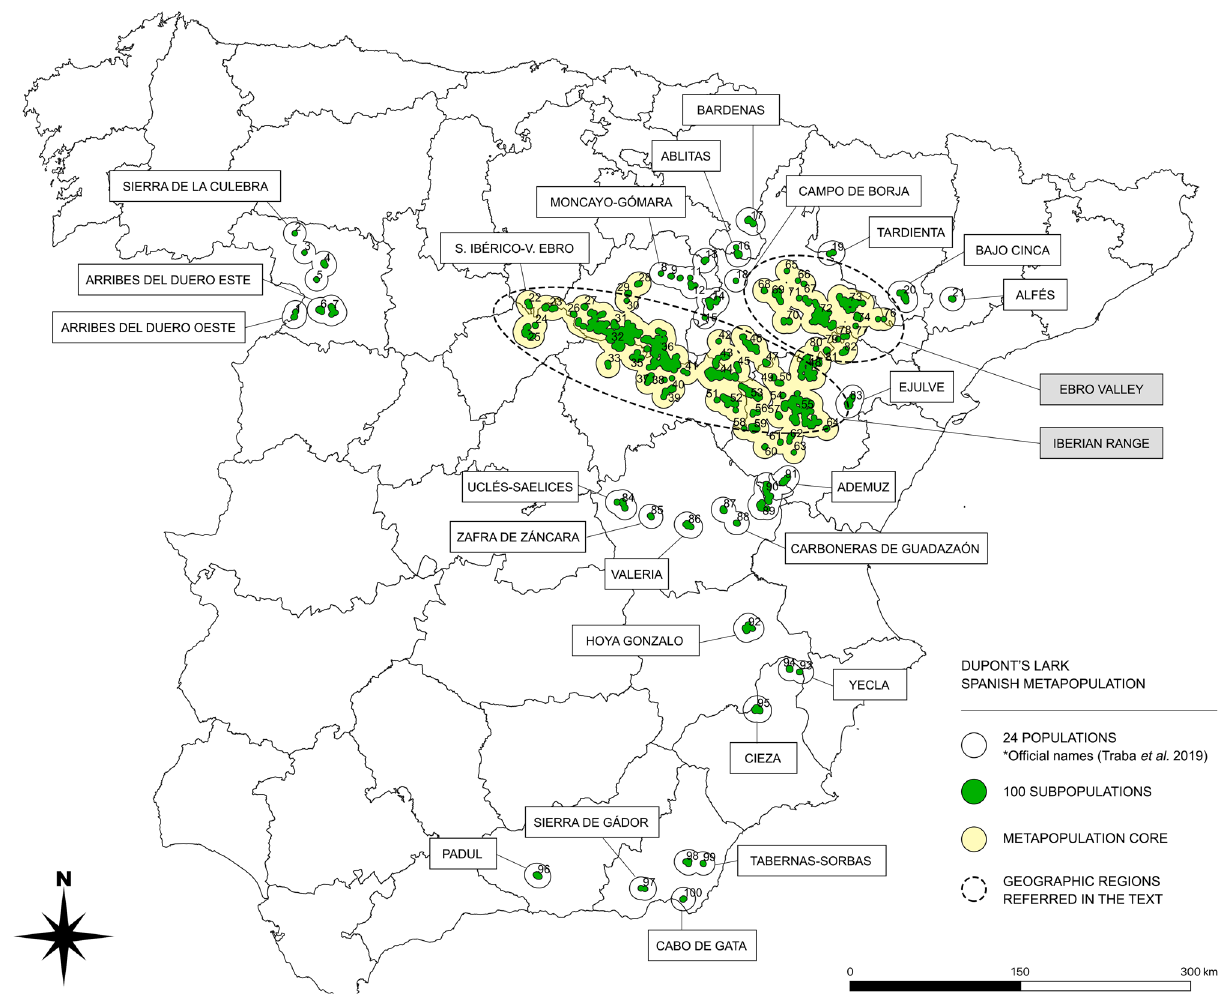
Figure 5. Dupont’s Lark Spanish metapopulation, comprising 24 populations (black contour) and 100 subpopulations (green). The core of the metapopulation (light yellow) is formed by two geographic regions (Iberian Range and Ebro Valley), merged in a large single population with the last definition criteria 49